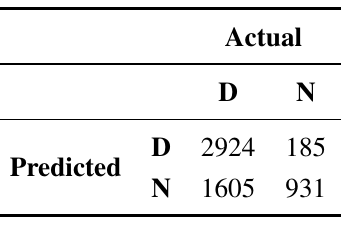
Table 2. Confusion matrix of binary classification as deleterious (D) or neutral (N).